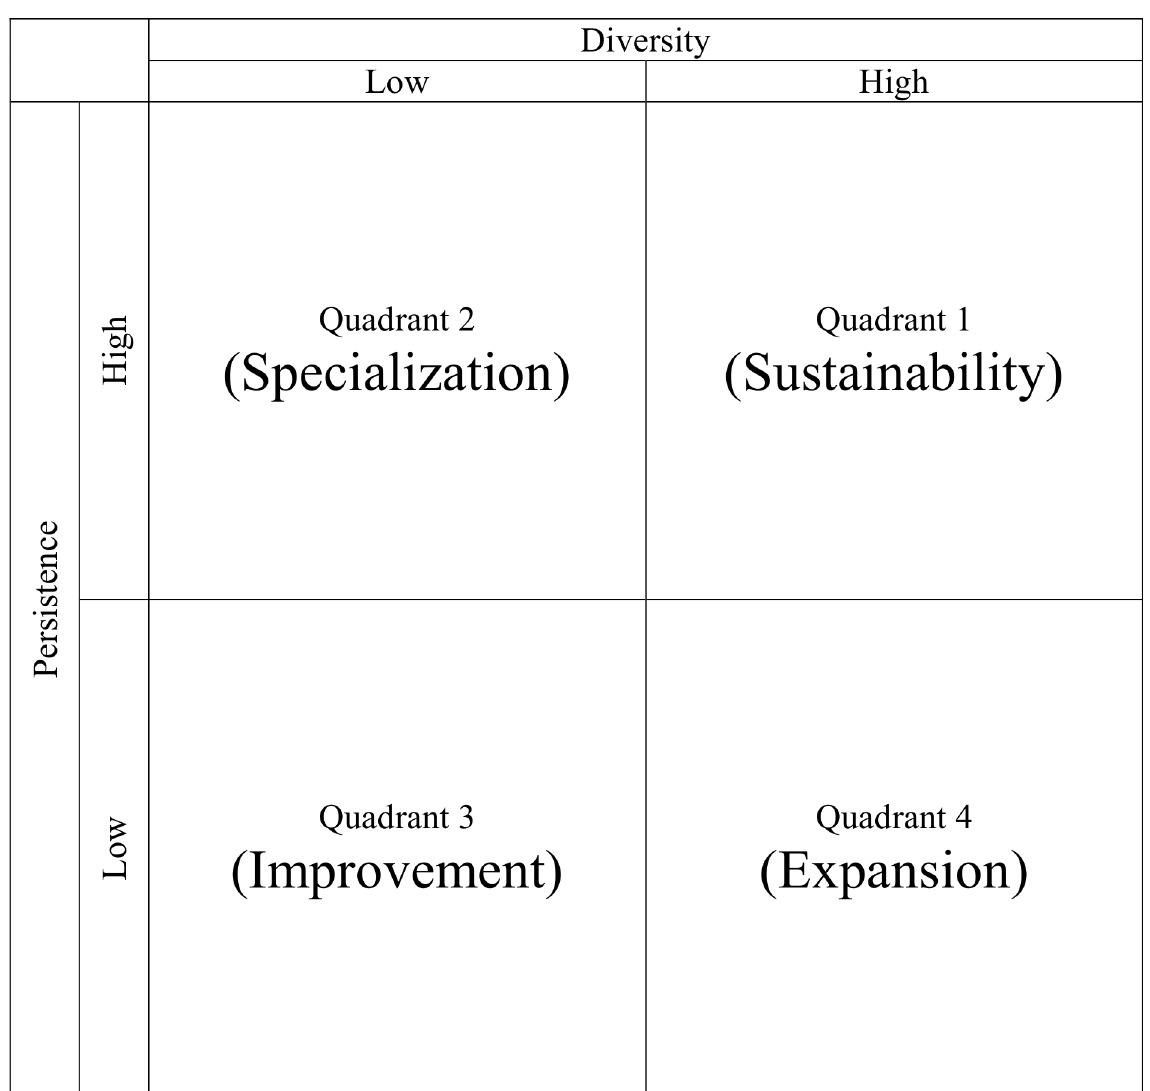
Fig 1. Analytical Framework for Understanding Technology